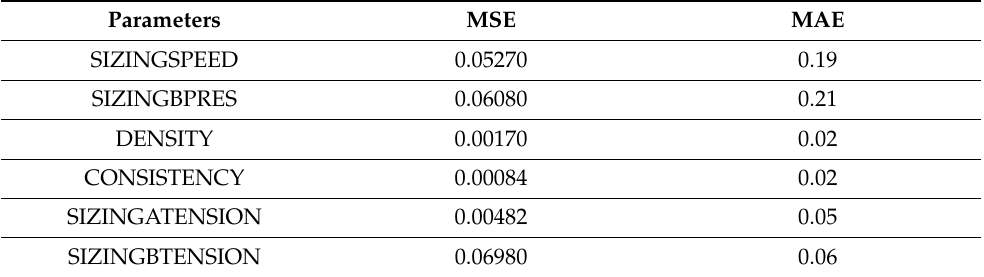
Table 13. Ridge regression results for the sizing process.